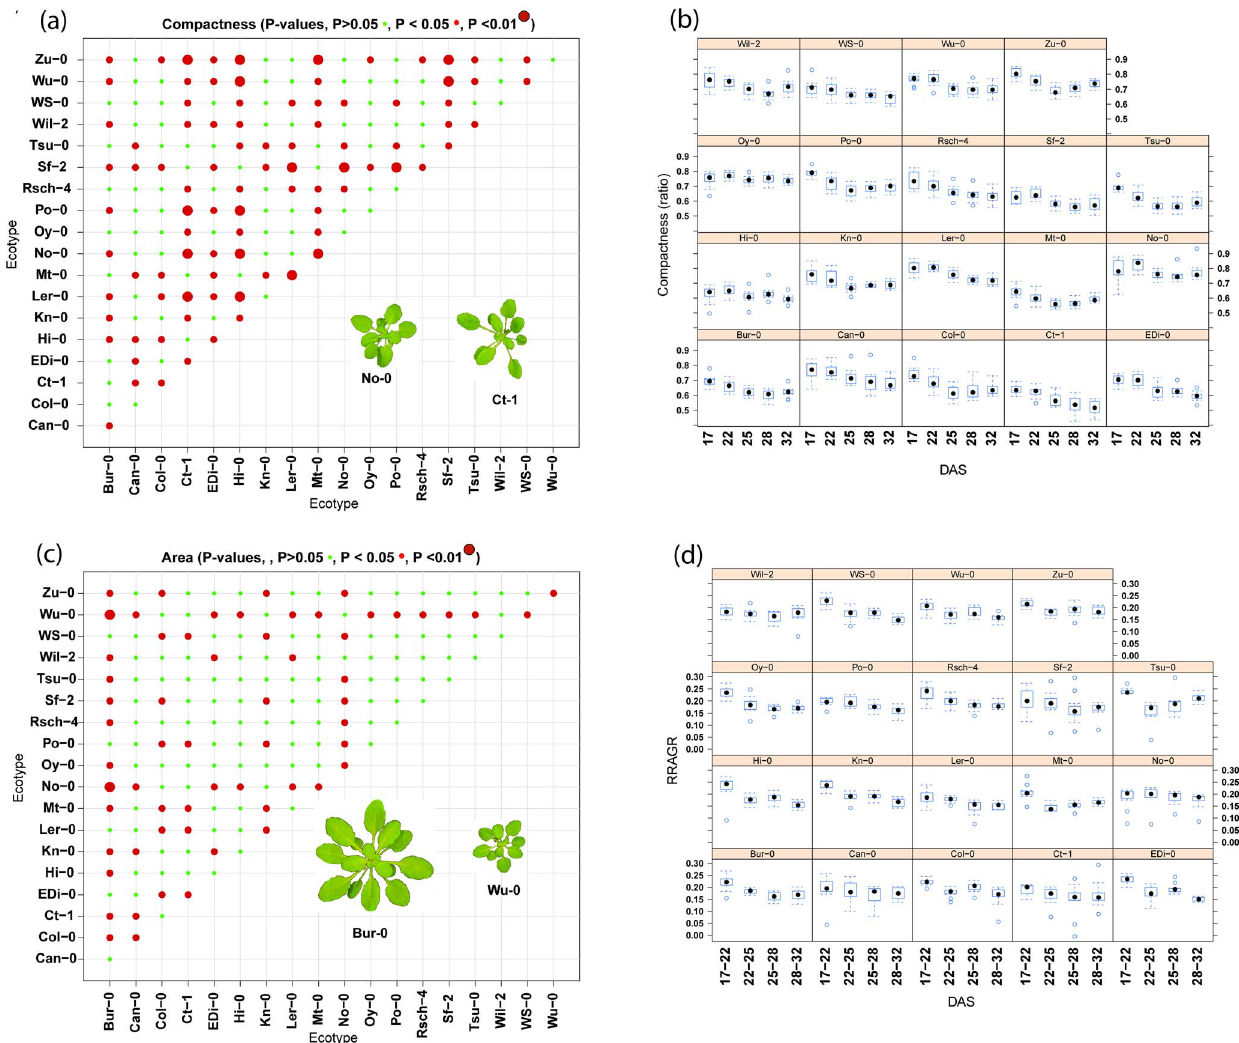
Figure 4. Multiple comparisons of Compactness and Area between ecotypes. Scatter plots showing significant (P . 0.05 . , P , 0.05 . , P , 0.01 . , Post-hoc Tukey test between ecotypes) differences between ecotypes for (A) ‘Compactness’ and (C) ‘Area’ and boxplots for (B) ‘Compactness’ and (D) Area over time. Images have been added to (A) and (B) to show range of ‘Compactness’ and ‘Area’.